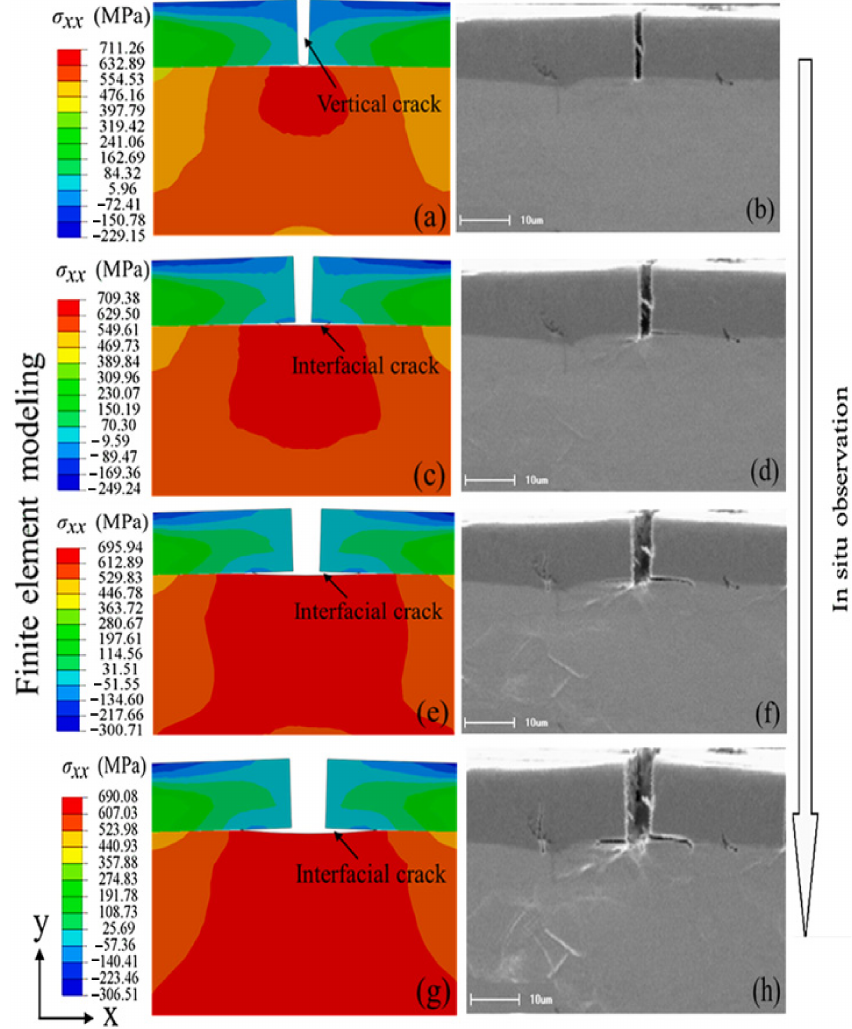
Figure 19. Simulation and SEM results of interfacial crack evolution at ε of ( a , b ) 2.50%, ( c , d ) 4.25%, ( e , f ) 7.02%, ( g , h ) 10.13%